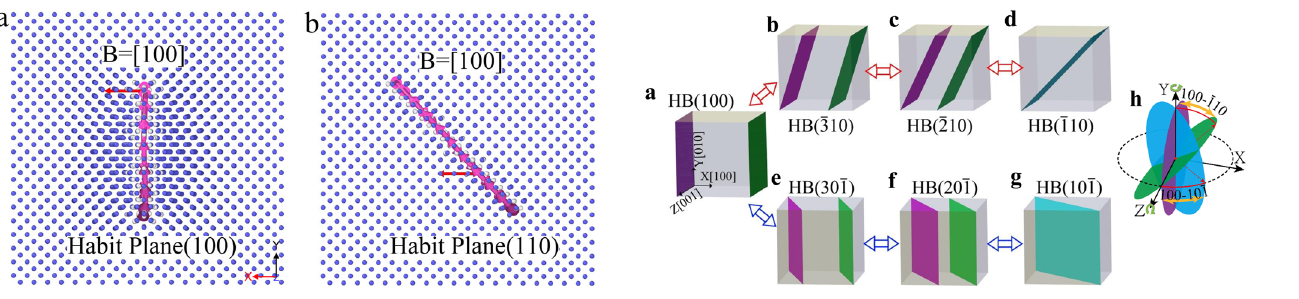
Fig. 1 Con fi guration of a <100> loop with its Burgers vector [100] located at different habit planes. a The (100) and b the (110) planes, respectively. In this case, the number of SIAs in the loop is 137. The loop is shown by the pink curve with arrows. The red arrows indicate the Burgers vector of Table 1 Energy states of [100] loops located on habit planes (HB) of the (100) and the (110), as a function of number of SIAs ( N SIA ) in the loops.